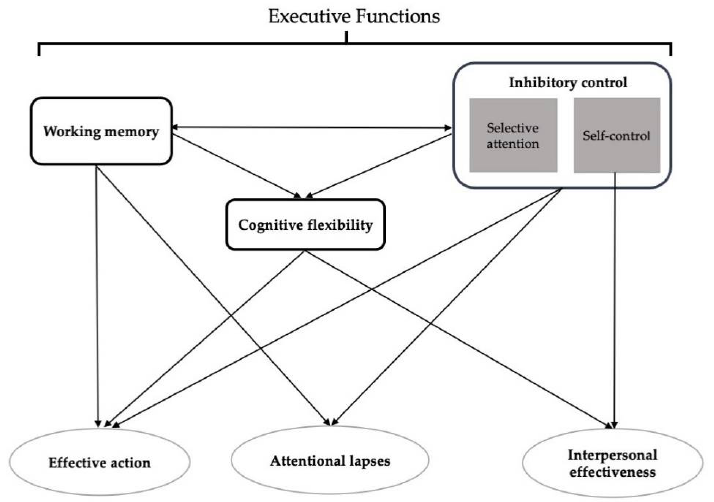
Figure 1. Cognitive processes associated with executive functions (adapted from Diamond [4]).